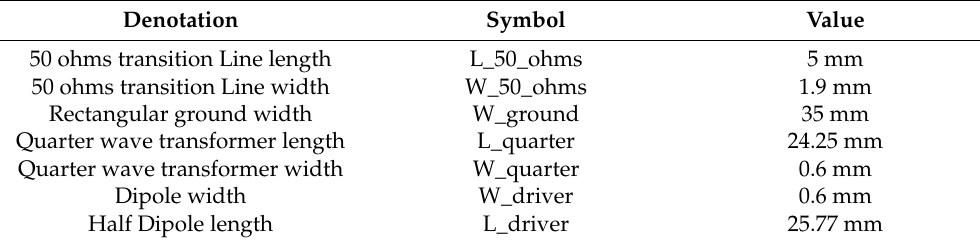
Table 3. Dipole results.